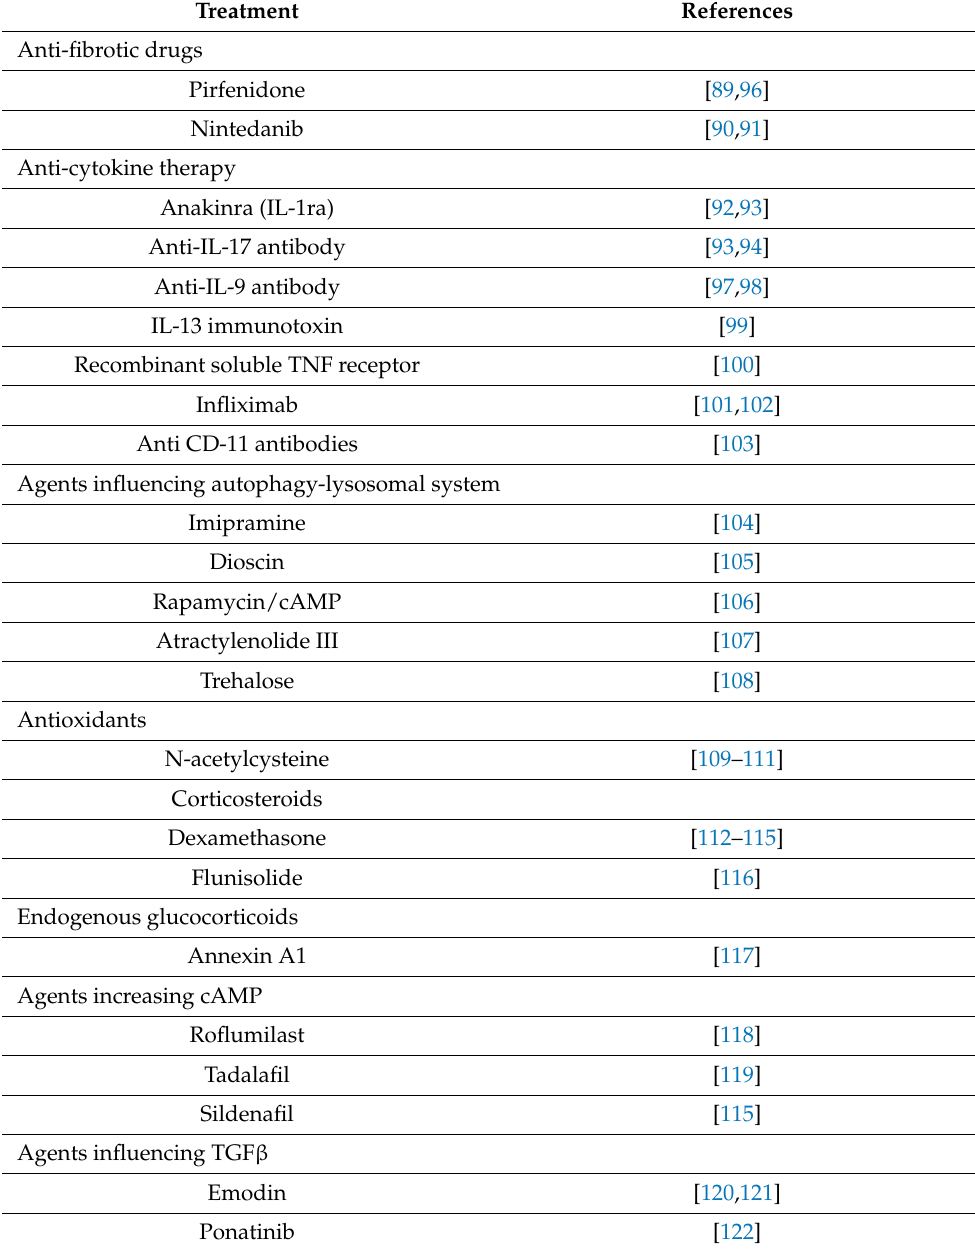
Table 1. Treatment possibilities tested in animal models of silicosis or